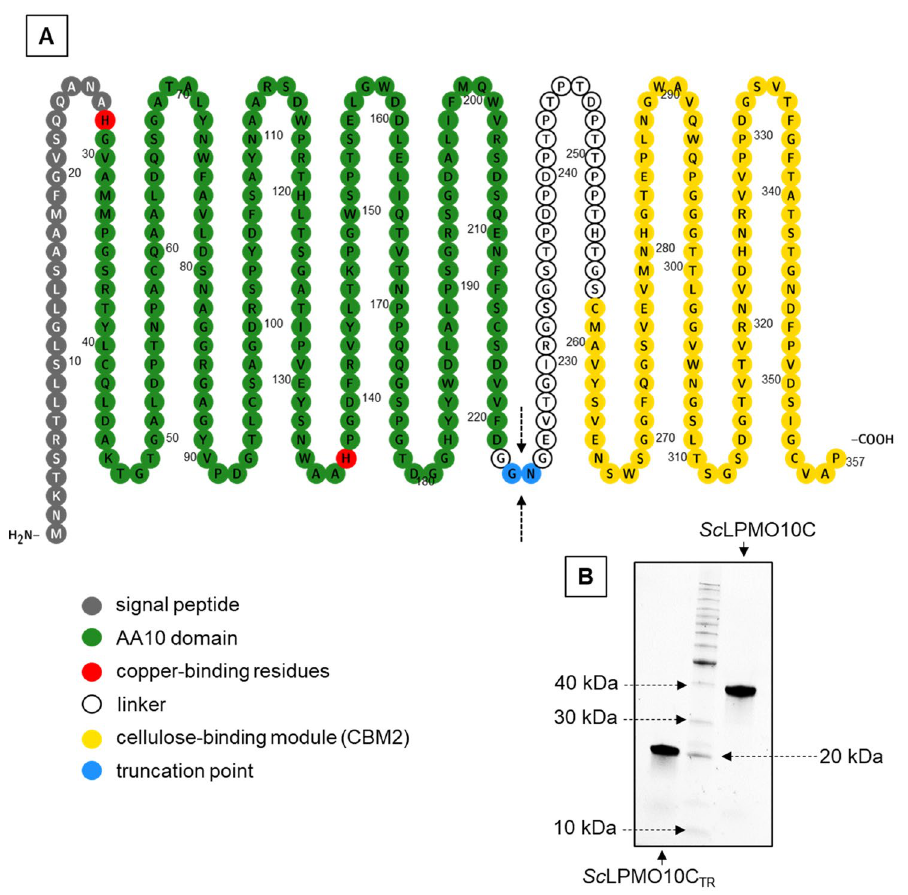
Figure 1. Domain architecture of Sc LPMO10C (panel A ) and SDS-PAGE of purified Sc LPMO10C and Sc LPMO10C TR (panel B ). Sc LPMO10C TR is a modified form of Sc LPMO10C produced by truncation of the cellulose-binding module as indicated by the blue color and the arrows. For expression, the native signal peptide was replaced by the signal peptide of Sm LPMO10A (CBP21), which is shown in the figure. Domain boundaries were annotated using Pfam (http:// pfam. xfam. org/), with minor manual adjustments based on inspection of the crystal structure of the catalytic domain (PDB: 4OY7) and the NMR structure of the cellulose-binding domain (PDB: 6F7E). The schematic representation of Sc LPMO10C was created with the Protter protein visualization tool (http:// wlab. ethz. ch/ prott er). See. Fig. S1 for the uncropped and unprocessed gel image used to create panel